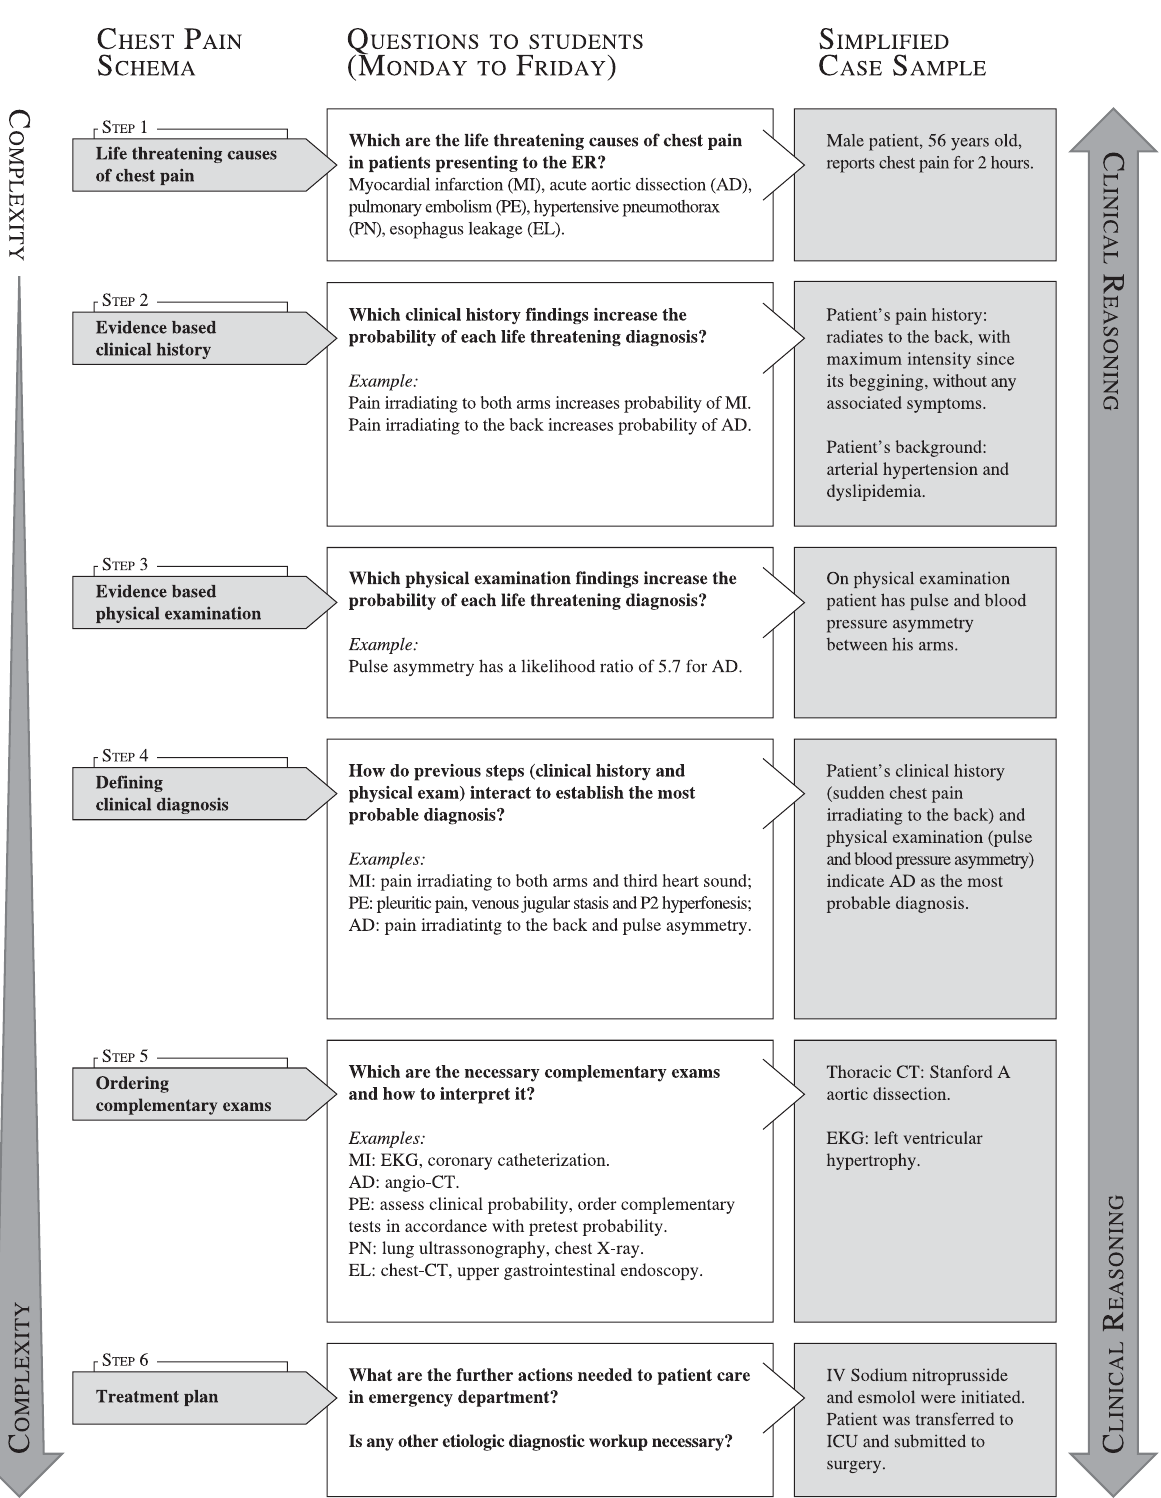
Fig 2. Virtual Rounds case construction — Chest Pain. At left, a schema is shown in six successive steps, discussed during the week. In general, one or two steps are discussed in a single day, from Monday to Friday. The following steps were addressed only after the previous had been accessed. At right, we provide a resumed Virtual Round model, with the main information that would be discussed at the online shared forums with students, having the schema as a guide.